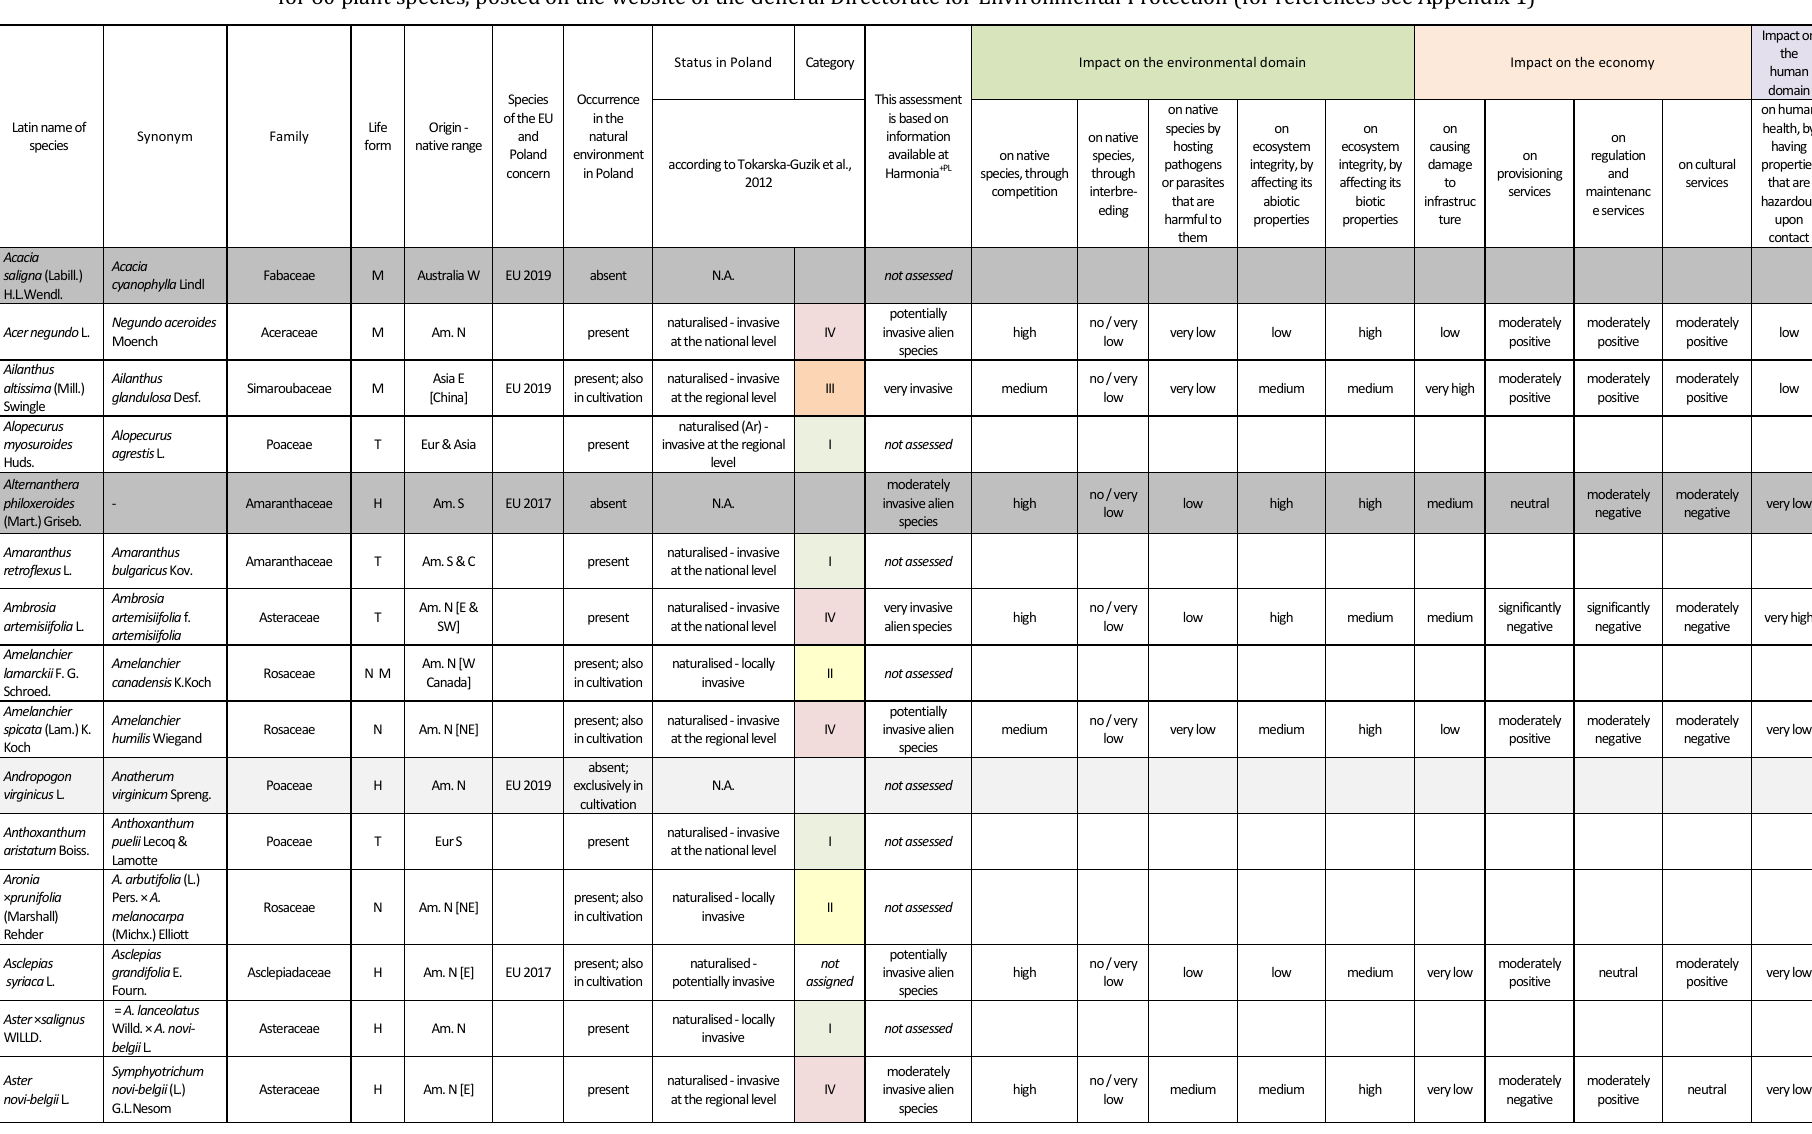
Table 2. The list of invasive alien plant species in Poland, including species of EU and Poland concern, uses the information contained in questionnaires assessing the degree of invasiveness for 60 plant species, posted on the website of the General Directorate for Environmental Protection (for references see Appendix